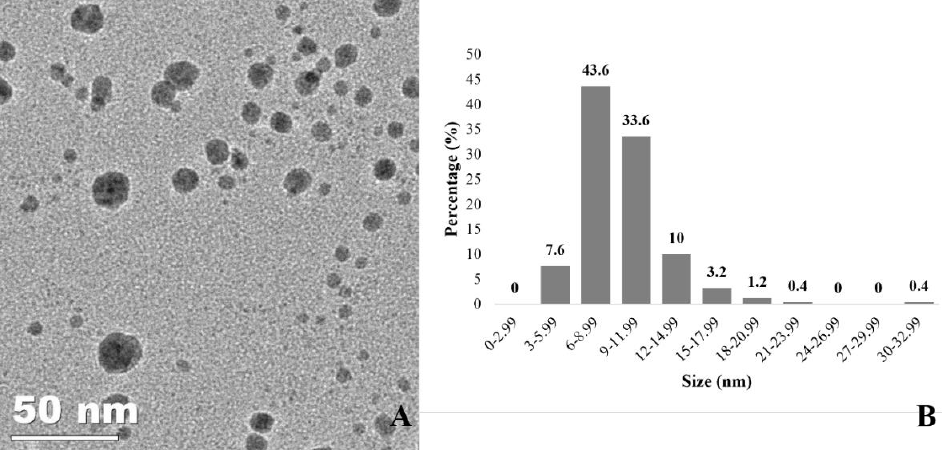
Figure 3. Biological AgNPs physicochemical characterisation. ( A ) TEM image (60000 × magnification, 50 nm scale) showing spherical shaped AgNPs synthesised by the fungus C. thermophilum . ( B ) Size distribution, with the measurement obtained using ImageJ software, with 8.93 ± 2.29 nm average size.